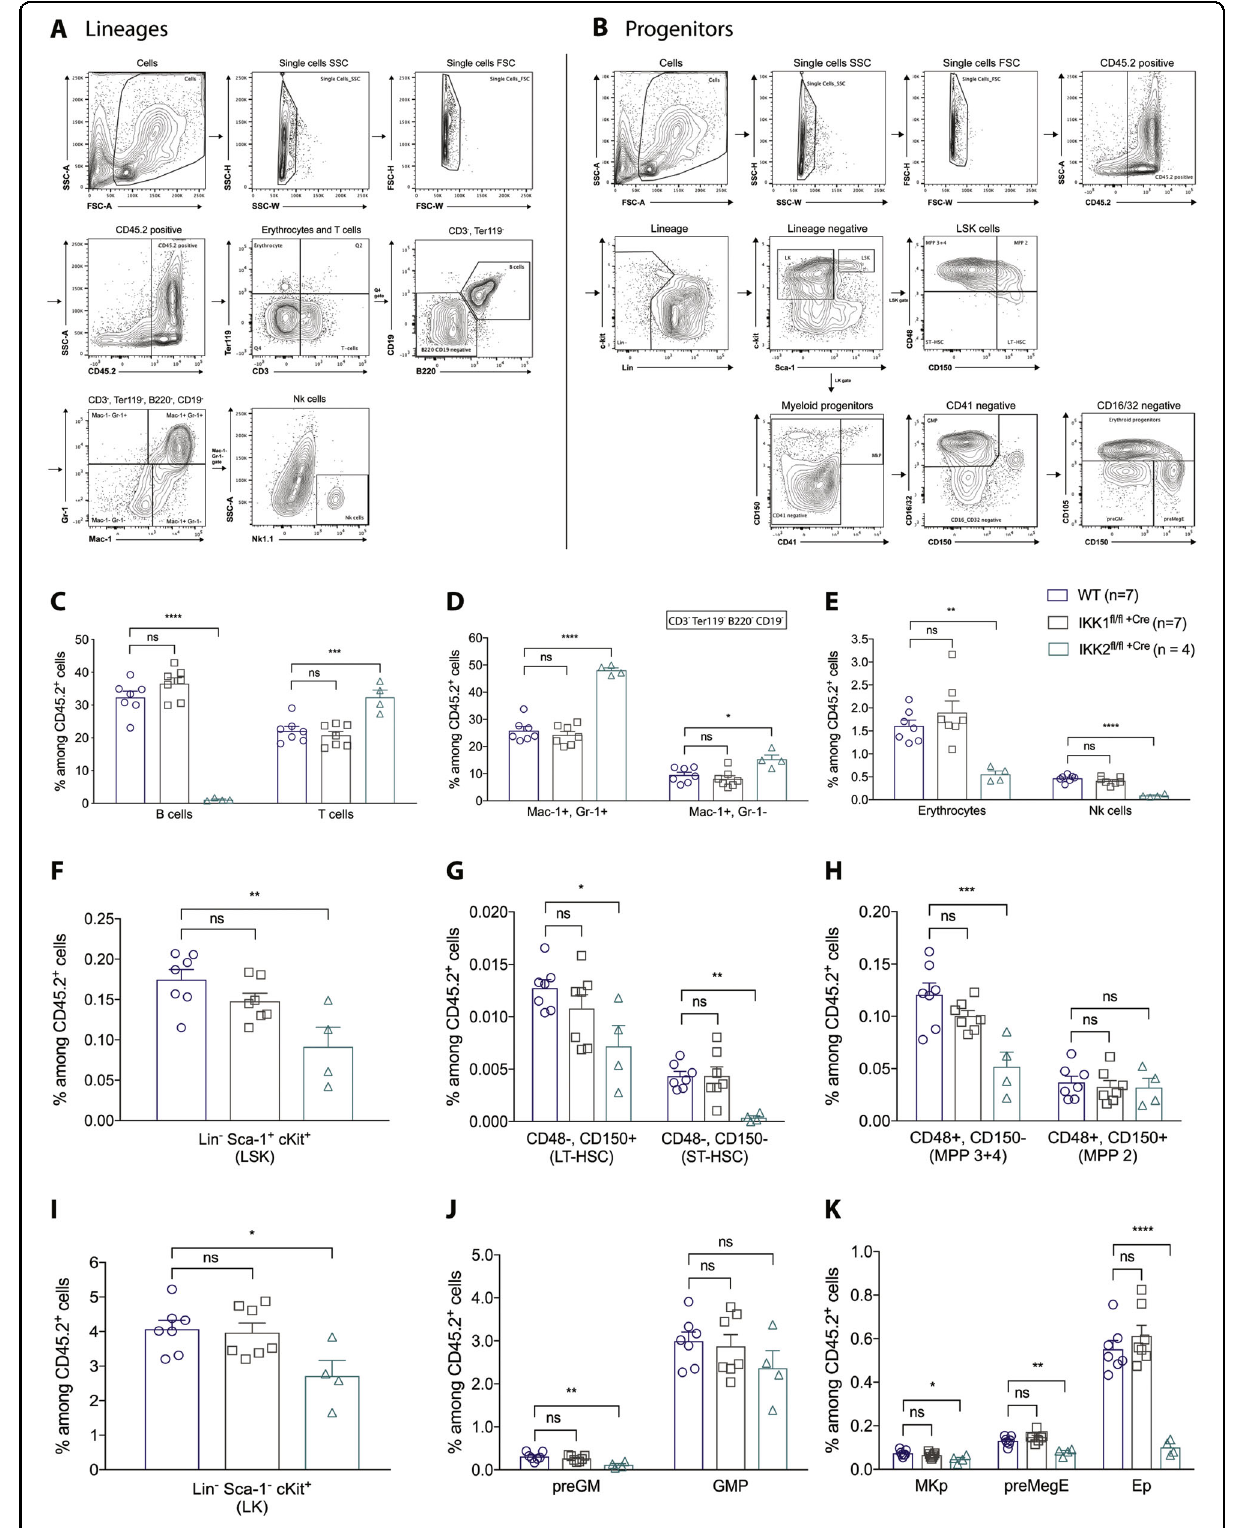
Fig. 4 (See legend on next